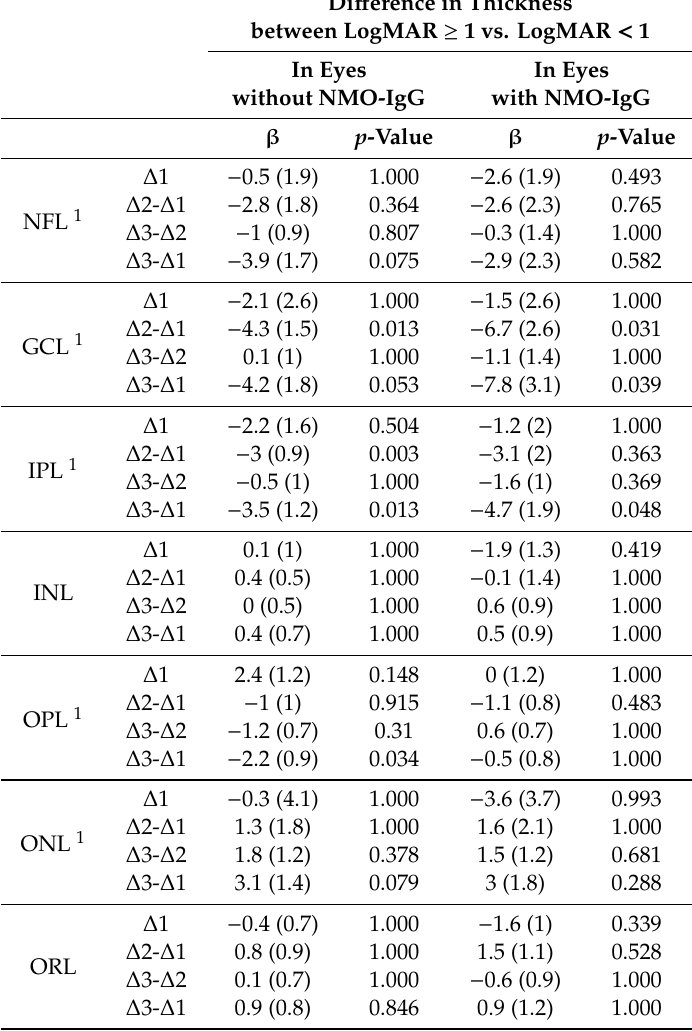
Table 5. Subgroup analysis showing di ff erences in the e ff ect of low visual acuity on changes in thickness between groups.